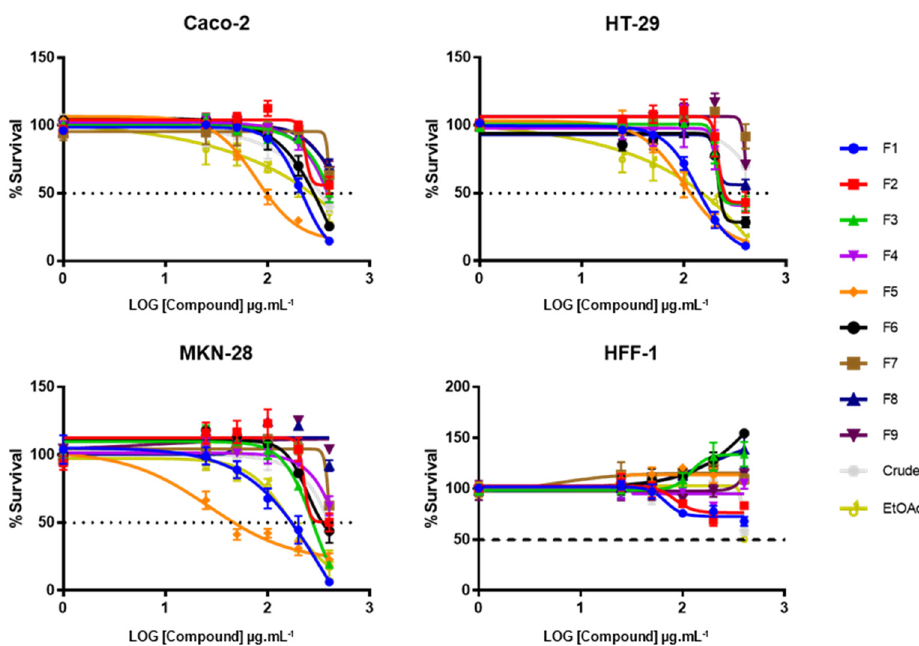
Figure 1. Effect of F. vesiculosus samples on the cell viability of Caco-2, HT-29, MKN-28, and HFF-1 cells after 48 h. Data are expressed as percentage of survival compared with the negative control and are presented as the mean ± SEM of at least three independent experiments.